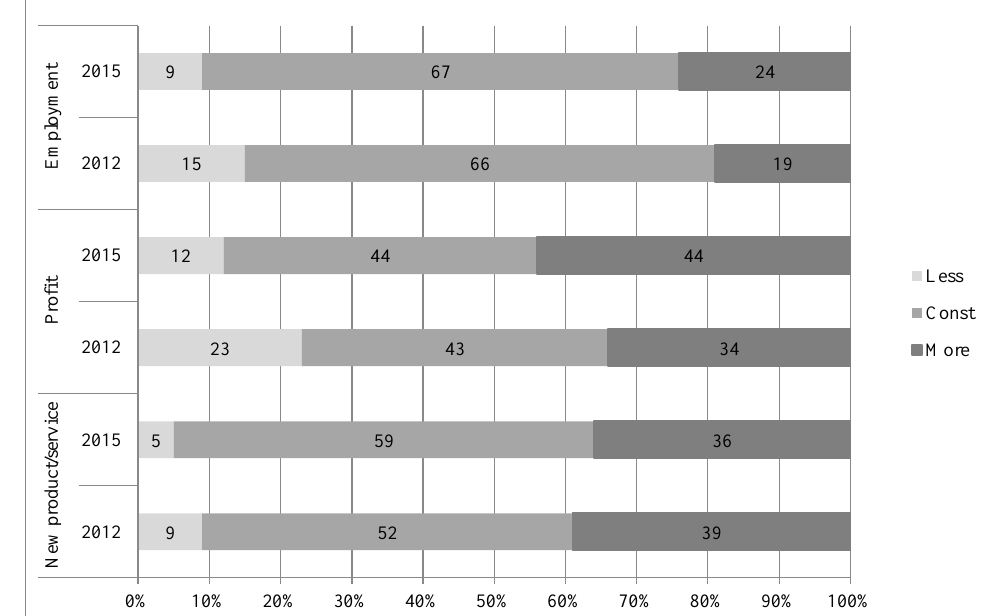
Figure 2. Serbia – Businessman's